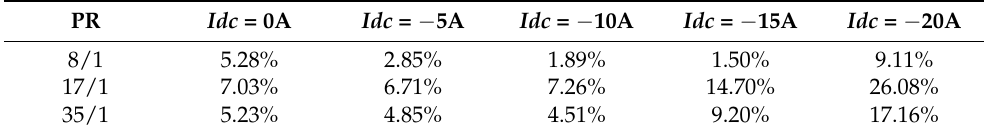
Figure 7. Evolution of ξ as Idc under different PRs.